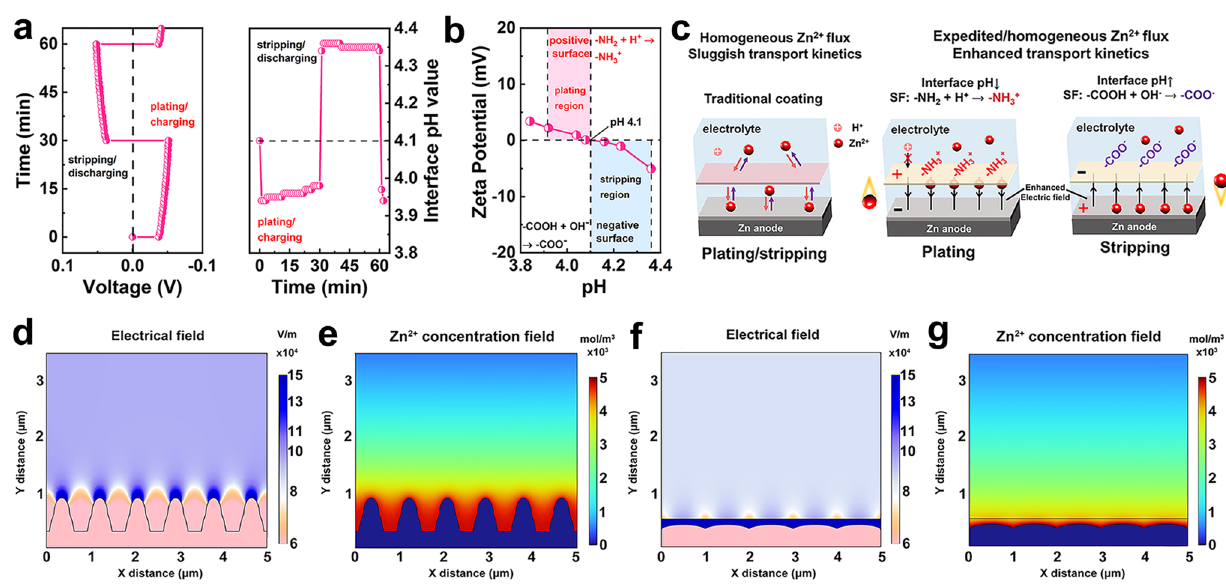
Fig. 2 Reversible electrical field controlled by interface pH. a Real‑time interface pH with the plating/stripping process of the Zn‑SF anode at 5 mA cm −2 . b Zeta potential of SF in the 2 M ZnSO 4 electrolyte with different pH. c Mechanism of the build‑in electrical field with dynamic interface pH. d‑g Simulated electric field and Zn. 2+ concentration field distributions on bare Zn ( d, e ) and Zn‑SF ( f, g